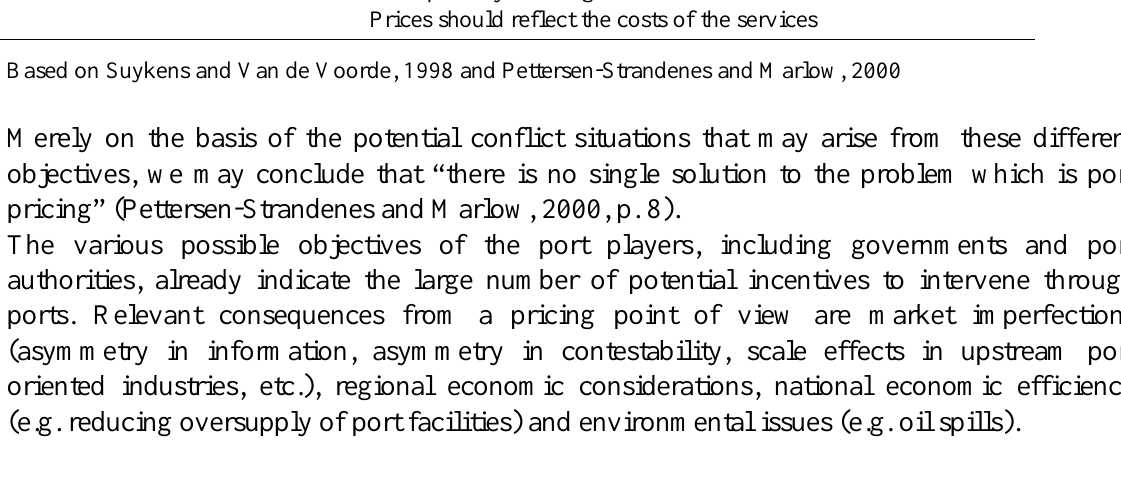
Prices should reflect the costs of the